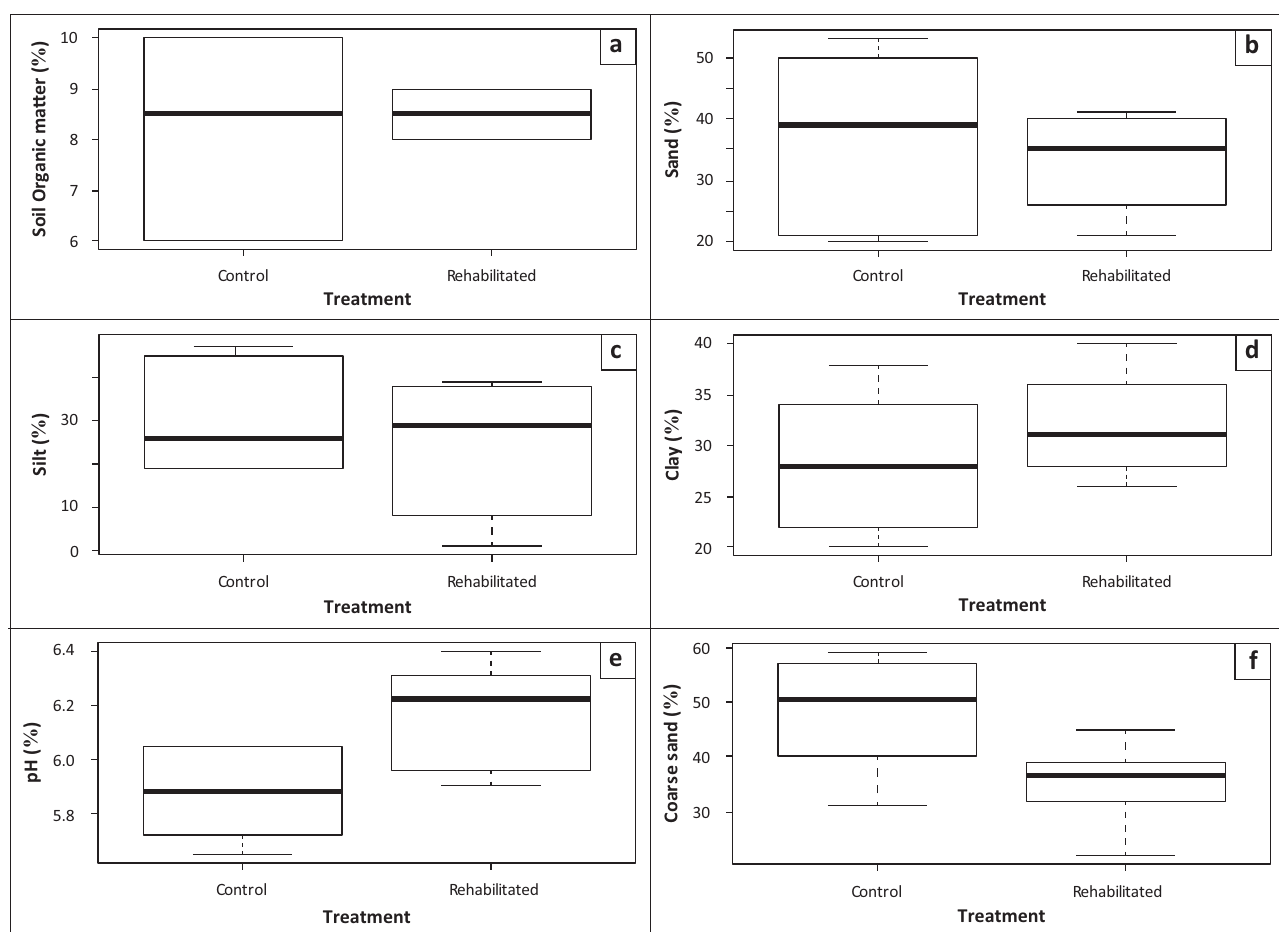
FIGURE 1-A3: Box plots indicating the properties of the soil collected from the different treatments: (a) percentage soil organic matter, (b) percentage sand, (c) percentage silt, (d) percentage clay, (e) pH and (f) percentage coarse